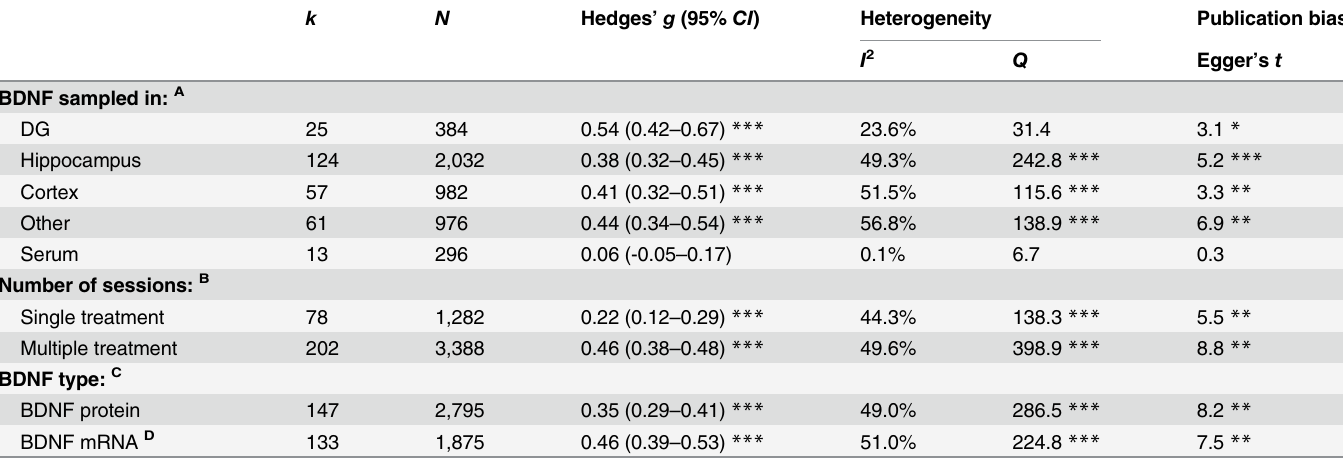
Table 2. Pooled effect-size estimates, heterogeneity and publication bias for the animal studies by sub-group meta-analyses indicated in the row. k N Hedges ’ g (95% CI